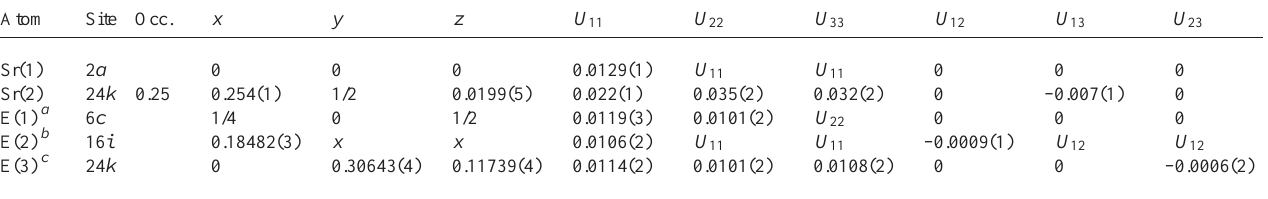
Table 2. Atomic coordinates and displacement parameters (in Å 2 ) .